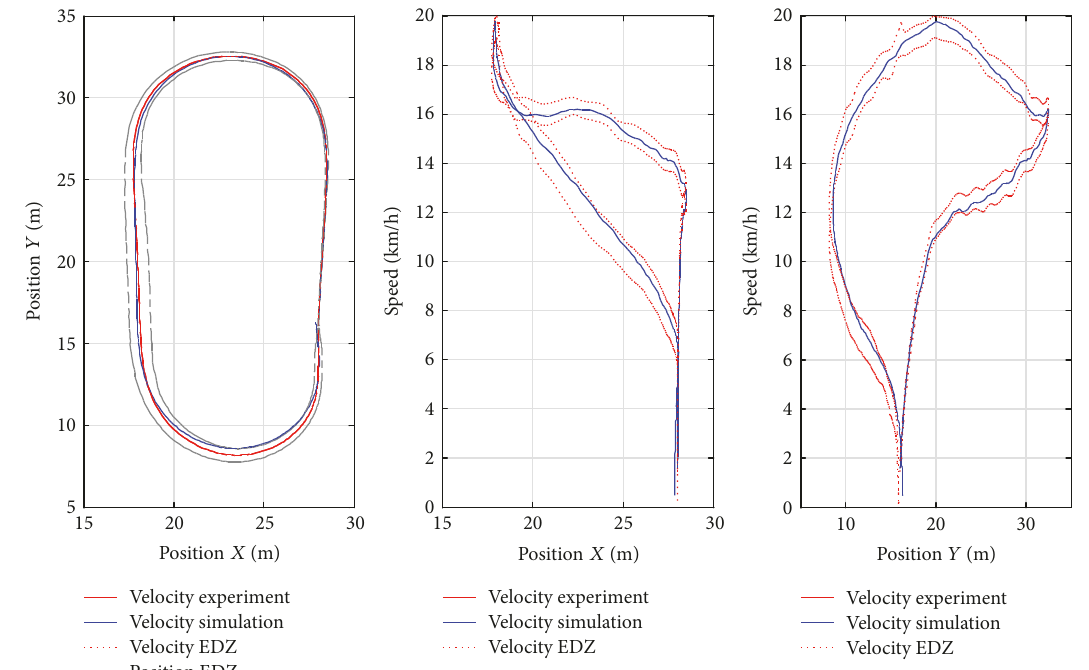
Figure 20: Validation combined dynamics: position-speed